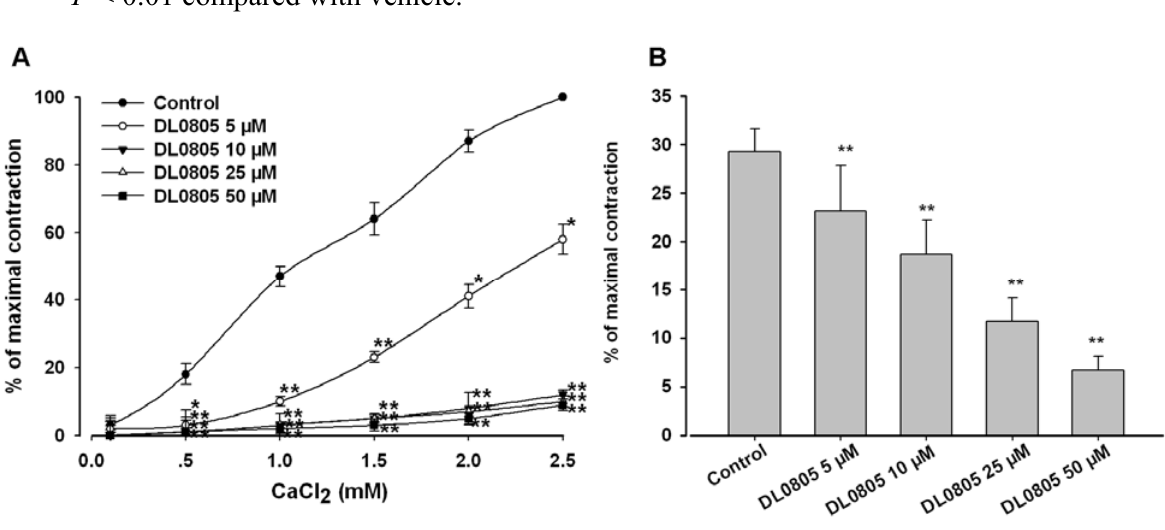
Figure 4. Inhibitory effect of DL0805 on the cumulative-contraction curve dependent on extracellular Ca 2+ influx induced by KCl (60 mM) in Ca 2+ -free solution added cumulatively CaCl (0.1~2.5 mM) ( A ) and on the NE (1 μ M) induced contraction in 2 Ca 2+ -free solution ( B ). Results are presented as means ± S.E.M., n = 6, * P < 0.05, ** P < 0.01 compared with